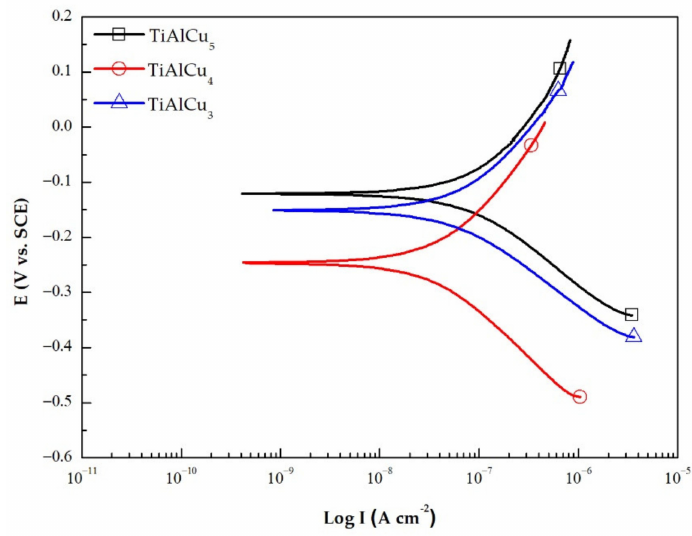
Figure 7. Potentiodynamic polarisation curves of TiAl 46 Cu x specimens with x = 3, 4 and 5